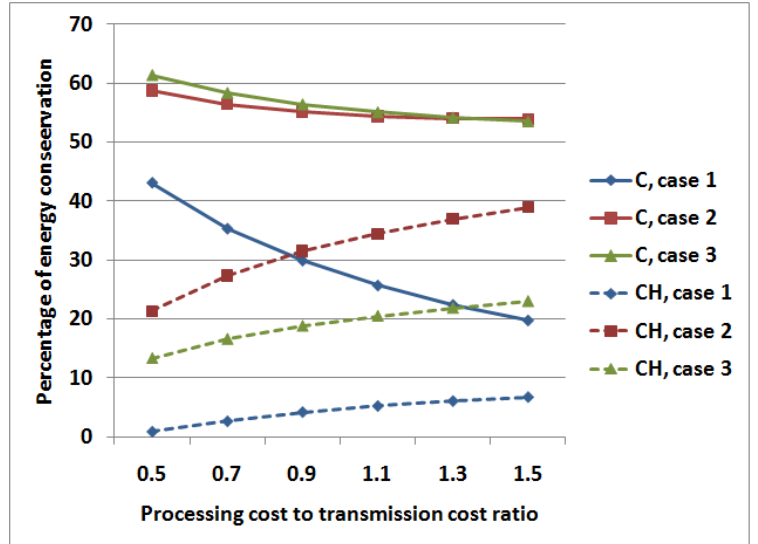
Figure 7. Percentage of energy conservation with respect to the ratio between processing cost and the cost to transmit 137 bytes of data, for cases UC-UE, NUC-UE and UC-NUE, for a density of 0 : 3 nodes per m 2 . Solid lines show energy conservation with respect to data processed only by the Coordinator; dashed lines show energy conservation with respect to data processed by every Cluster